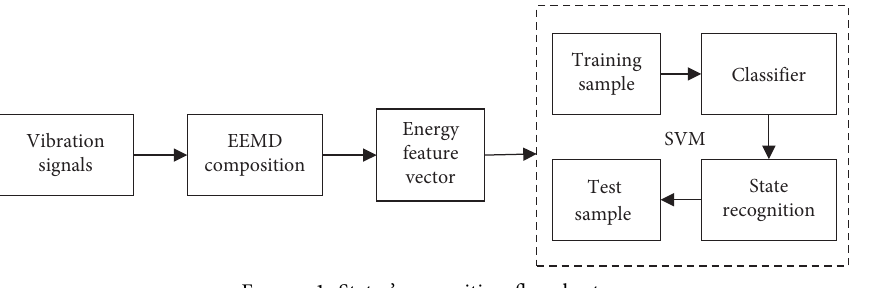
Figure 1: States’ recognition flowchart.